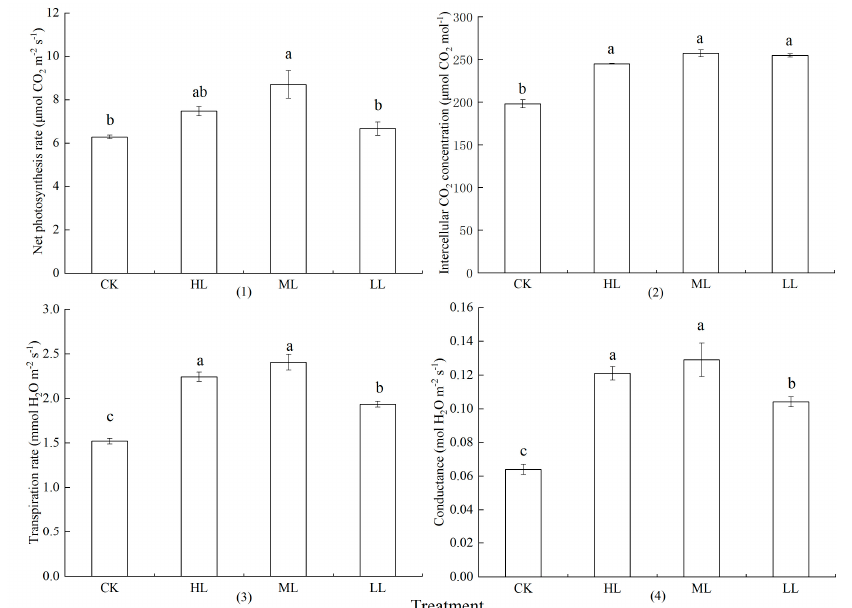
Figure 3. The photosynthesis rate ( 1 ), intercellular CO 2 concentration ( 2 ), transpiration rate ( 3 ), and conductance ( 4 ) of J. regia f. luodianense seedlings treated with different light intensities. Different lowercase letters represent significant differences between treatment groups ( p < 0.05). CK: 100% full light treatment; HL: 75% full light treatment; ML: 50% full light treatment; LL: 25% full light treatment.